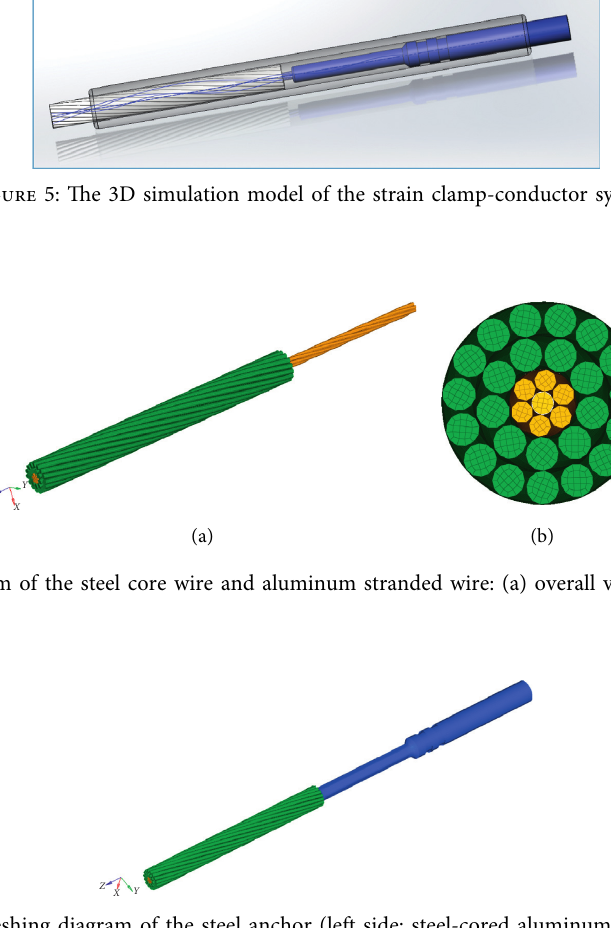
Figure 7: Meshing diagram of the steel anchor (left side: steel-cored aluminum stranded